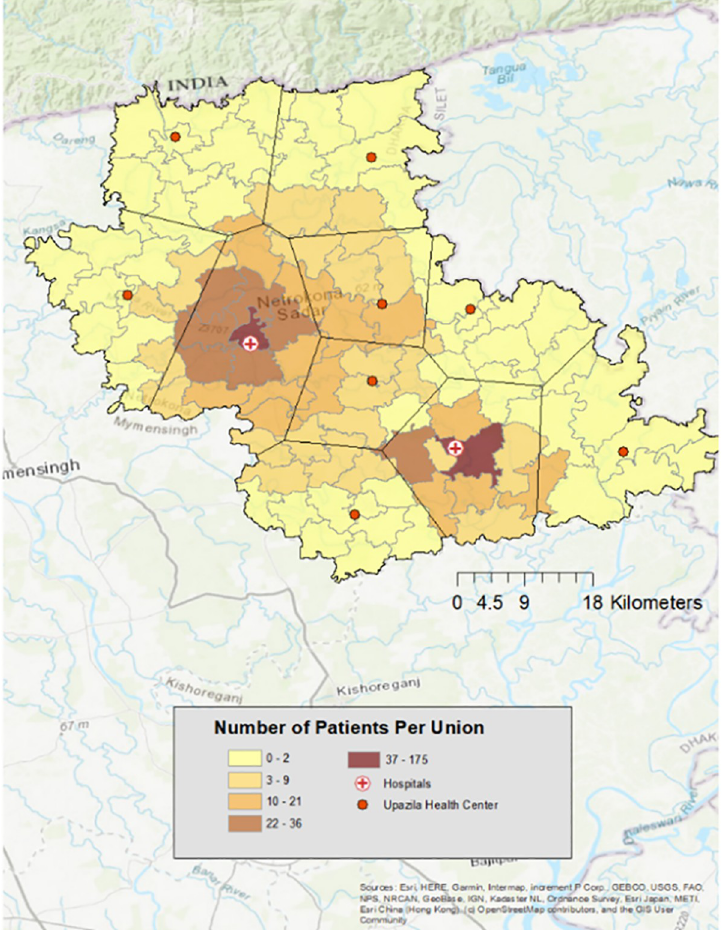
Fig 1. Geospatial distribution of 827 patients by administrative unit (union) and proximity to district hospitals. Basemap: World Topographic Map [29].